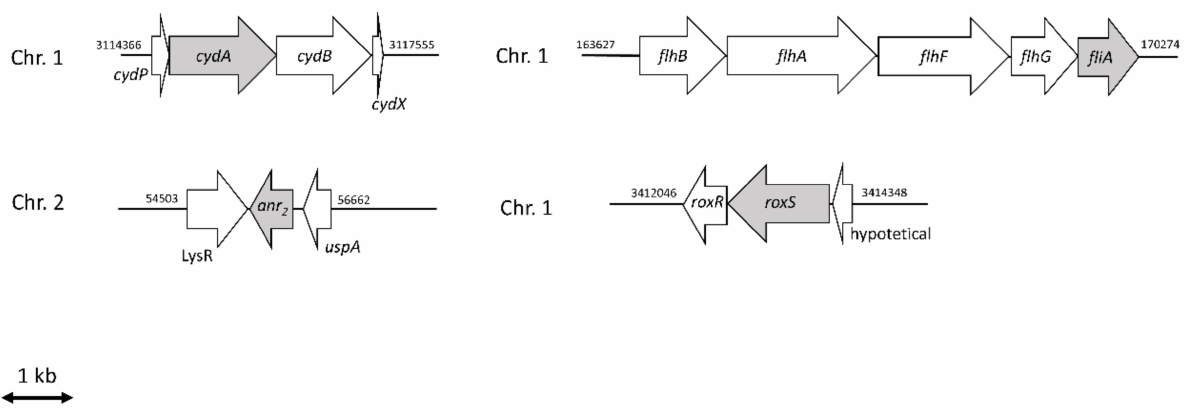
Figure 3. Genomic localization of the genes cydPABX encoding a cytochrome bd oxidase, anr 2 coding for a Crp-Fnr type regulator, fliA encoding the flagellar sigma factor and the roxS/roxR regulatory genes. The genes that have been mutated are highlighted in grey. Chr. = chromosomal localization. Numbers refer to the genomic